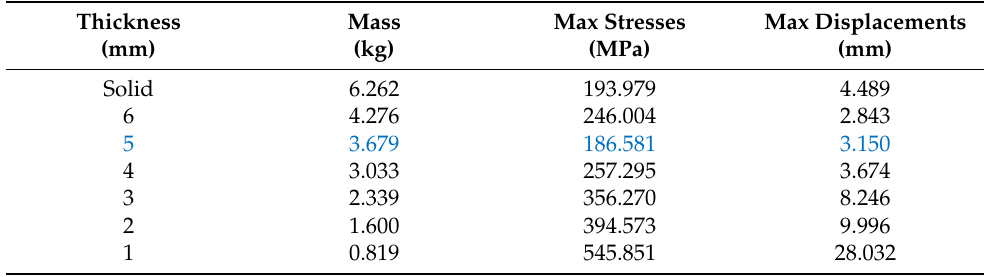
Figure 10. Displacement curves and maximum stresses for different values of rotor blade thickness 1. Table 4. Displacements and maximum stresses for different values of the thickness and mass of the rotor blade